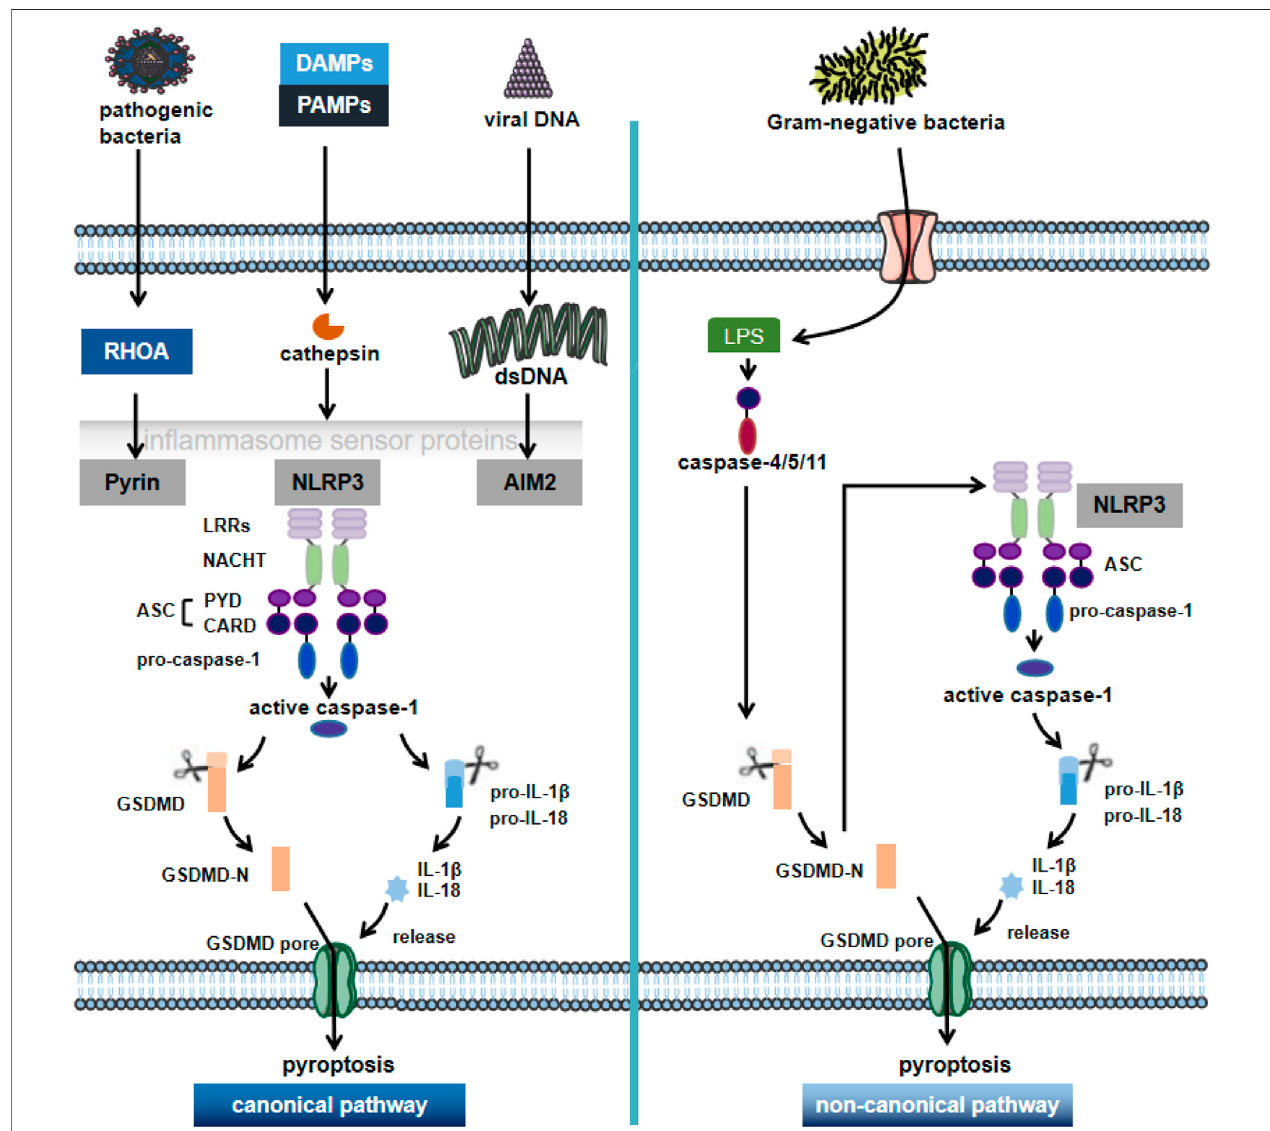
FIGURE1| Thecanonicalpathway andnon-canonicalpathwayofpyroptosis.Pyroptosisisanovelpro-in fl ammatoryregulatorofcelldeath.Dependingonthekey molecular patterns involved in the activation and execution steps, they can be divided into the canonical pathway and non-canonical pathway. In the caspase1- dependent pyroptosis pathway, cells can activate in fl ammatory vesicles to trigger pyroptosis in response to multiple factors, activating the respective in fl ammatory vesicles (including NLRP3, AIM2 or pyrin) through the action of PAMPs and DAMPs; NLRP3 recruits ASC and pro-caspase-1 through various pathways, causing activation of caspase-1 and maturation and secretion of pro-in fl ammatory cytokines such as IL-1 β and IL-18. GSDMD-N is formed by the cleavage of in fl ammatory cystathione, triggering the rupture of cell membranes and promoting the release of in fl ammatory factors, cell swelling and pytoptosis. In the non-canonical pathway, the Gram-negative bacterial cell wall fraction LPS activates caspase 4/5/11, which mediates pyroptosis by directly triggering pyroptosis through the cleavage of GSDMD. NLRP3:NOD-likereceptorprotein3;AIM2:inmelanoma2;PAMPs:pathogen-associatedmolecularpatterns;DAMPs:danger-associatedmolecularpatterns;GSDMD: gasdermin D; LPS: